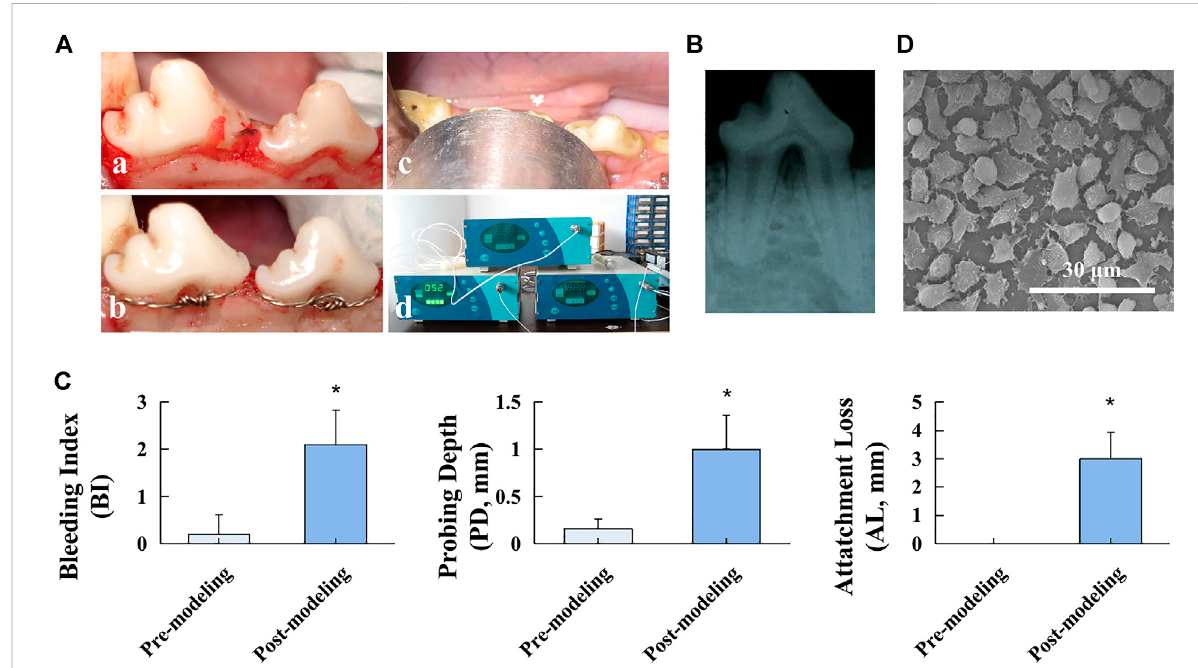
FIGURE 1 BeagleFImodelestablishment. (A) Modelingprocedures:a. fl apelevation,b.establishmentofthe “ U ” -shapeddefectandstainless-steelligature fastening, c. LIPUS treatment, and d. ultrasonic therapeutic device. (B) Postoperative radiographic observation. (C) Clinical assessment of BI, PD, and AL before and after the modeling procedure. Data are presented as mean ± SD. * p < 0.05. (D) SEM image of the PTFE